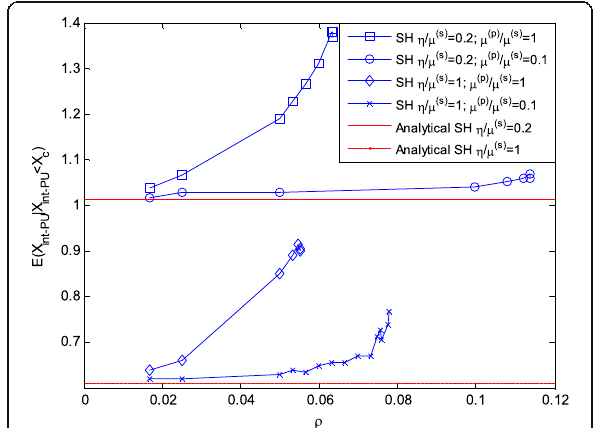
Fig. 11 Mean of the conditional call interruption time given that calls are interrupted by the arrival of PUs for different values of the primary channel utilization factor ( ρ )